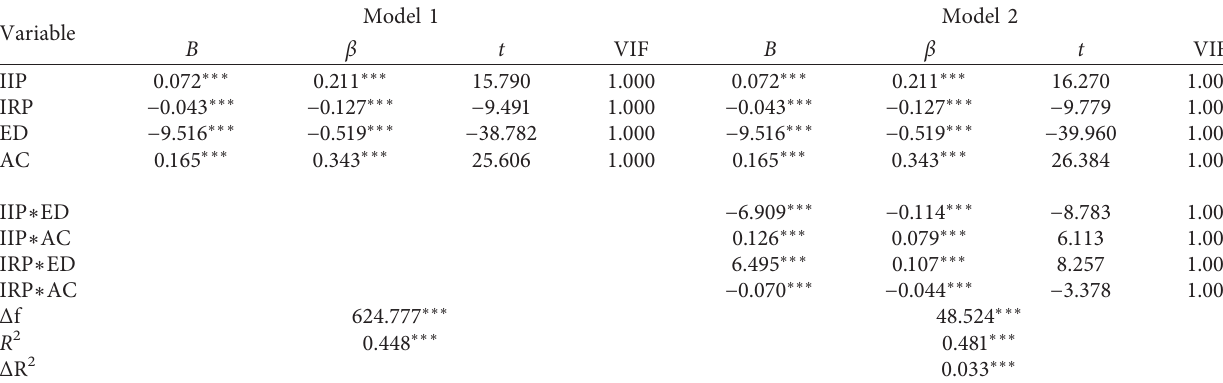
Table 1: Regression results.